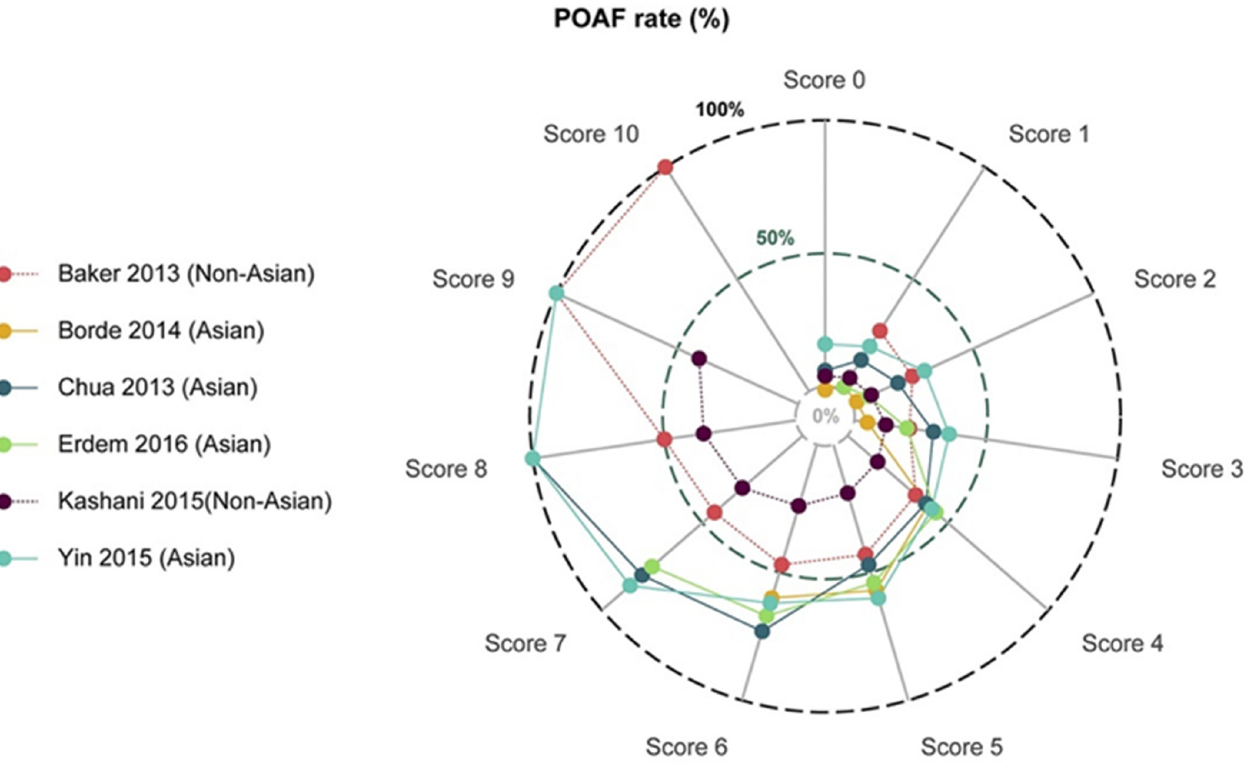
Figure 3. POAF incidence corresponding to each CHA 2 DS 2 -VASc score according to various trials carried out in Asian and non-Asian patients [44].